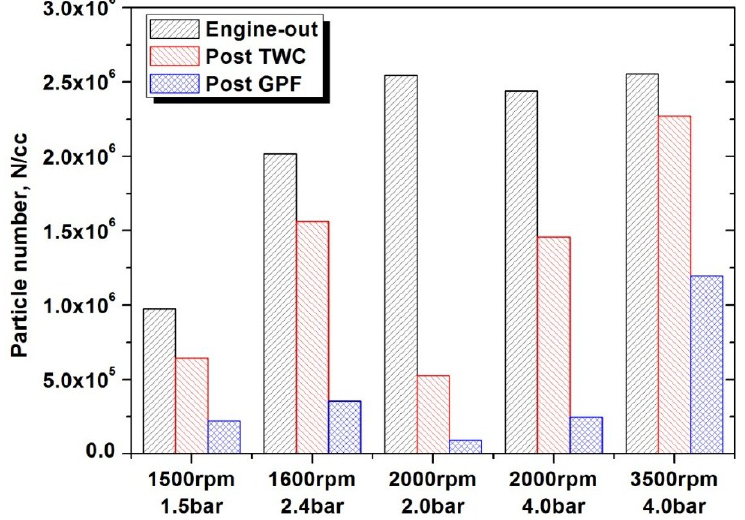
Figure 4. Total particle numbers with GDI and GPF-GDI engine in various part-load conditions; (start of injection (SOI), 300°–304° CA before top dead center (BTDC); Lambda = 1.0; spark advance (SA) = minimum spark advance for the best torque